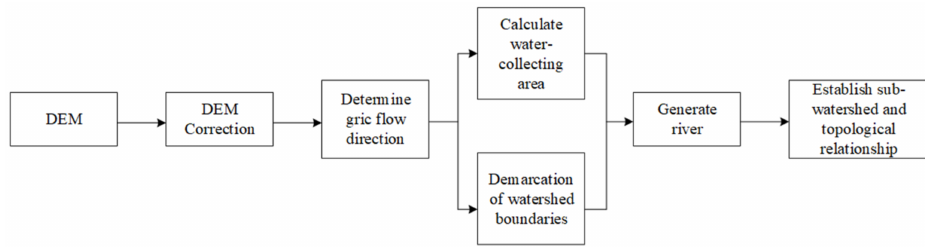
Figure 2. Schematic diagram of sub-watershed division process and establishment of confluence